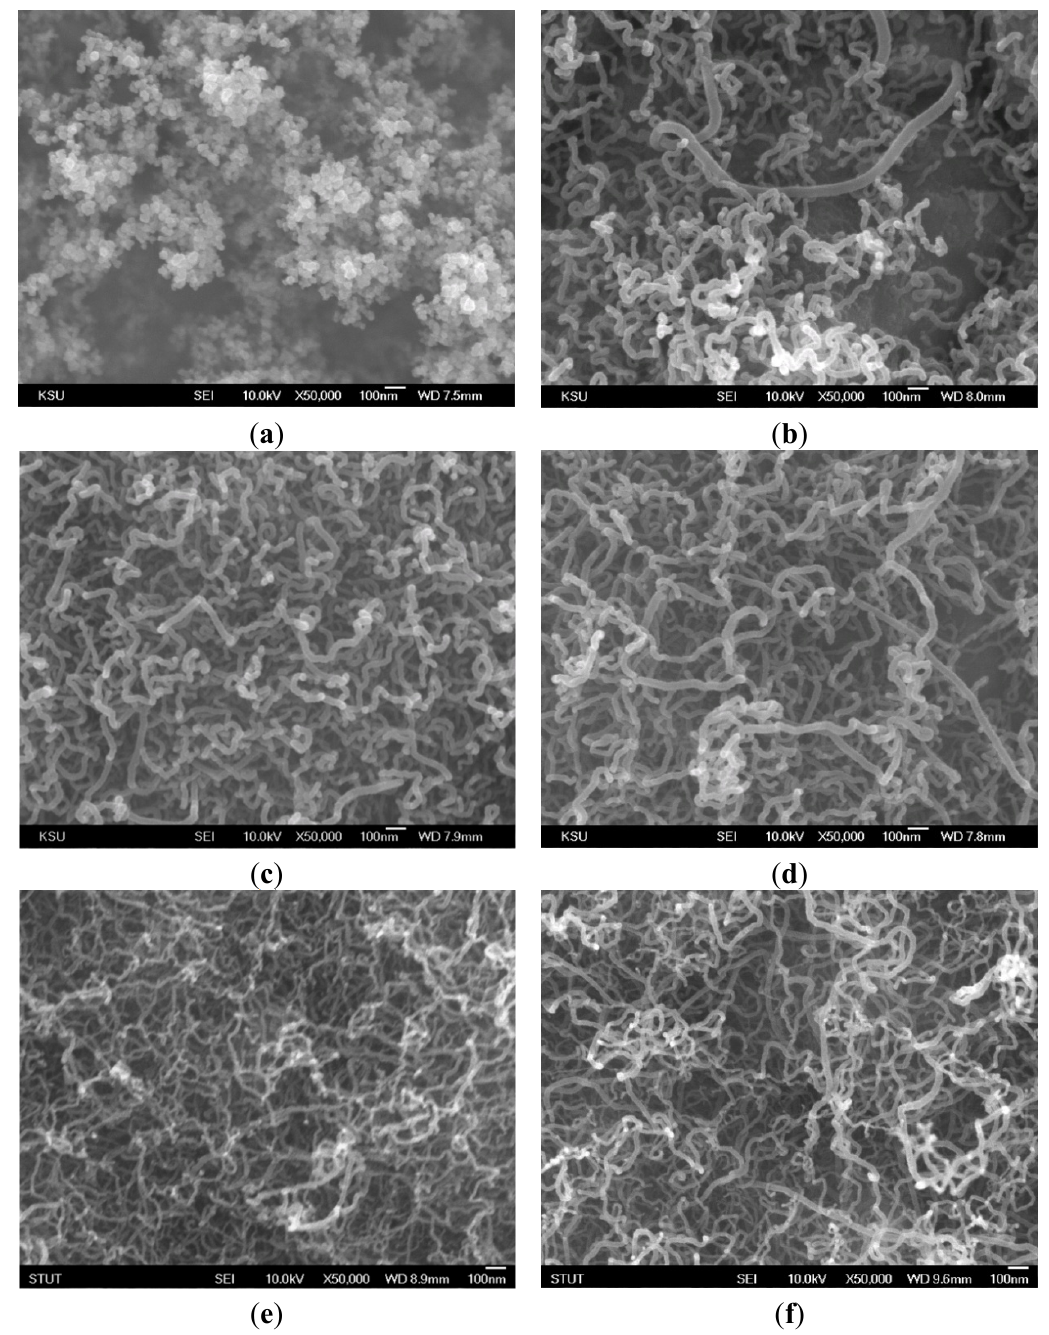
Figure 5. SEM images of carbon nanomaterials synthesized at z = 10 mm for f values of ( a ) 20; ( b ) 70; ( c ) 80; ( d ) 85; ( e ) 90; and ( f ) 95